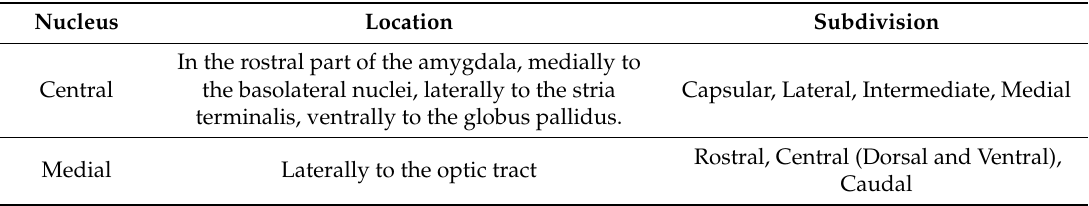
Table 2. Division and subdivision of centromedial amygdala nuclei according to